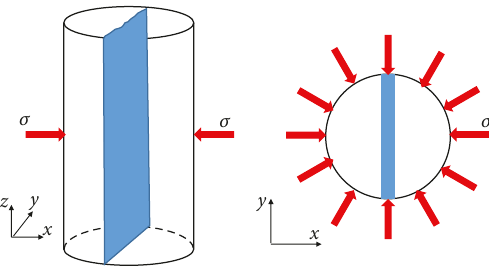
Figure 11: Sketch of rock specimen and fi ssure